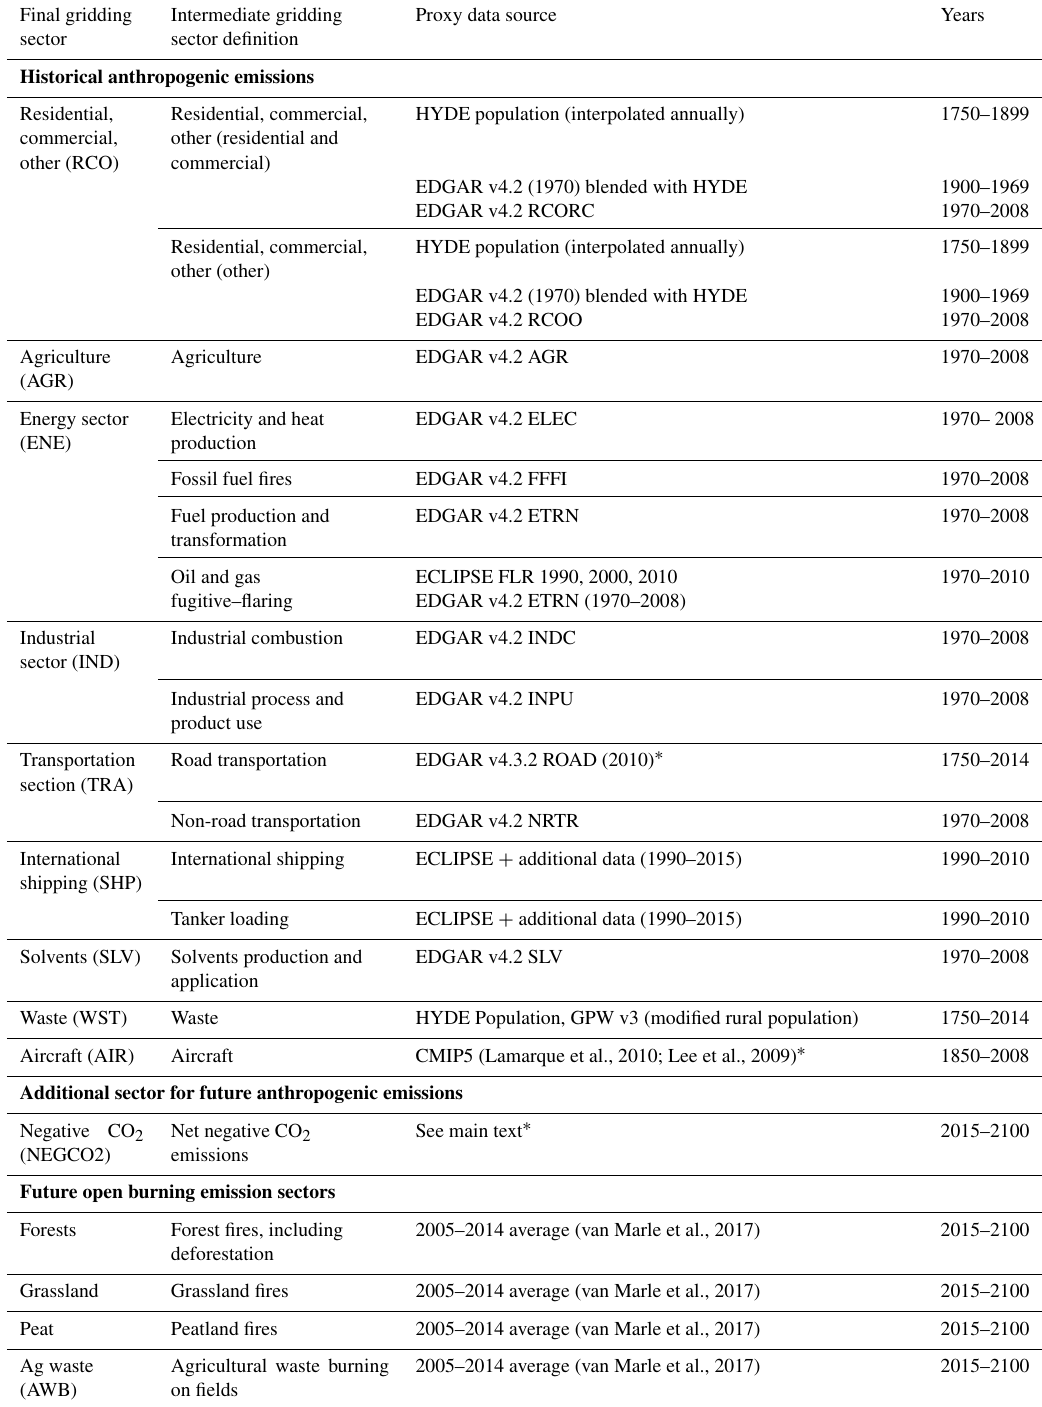
Table 2. Proxy data used for gridding anthropogenic emissions data, adapted from Hoesly et al. (2018). Gridding proxies marked with an asterisk ( ∗ ) do not vary in time. Future emissions use the same final gridding sectors, with the addition of four sectors for open burning emissions (e.g., agricultural waste burning on fields (AWB), forest burning, grassland burning, and peatland burning) and an additional sector for net negative CO 2 emissions (NEGCO2). A decadal average (2005–2014 avg.) for open burning proxy data was used for future emissions as indicated. Anthropogenic sector definitions can be found in Hoesly et al. (2018). Note that, except for international shipping, all future emissions used proxy data at the country and sector level that did not change over time; see the main